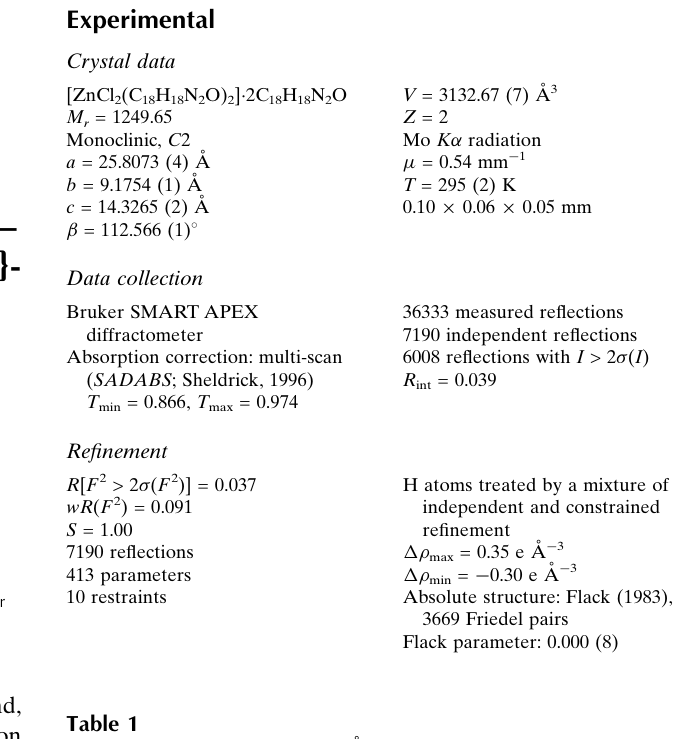
Selected geometric parameters (A˚ , (cid:2) ).